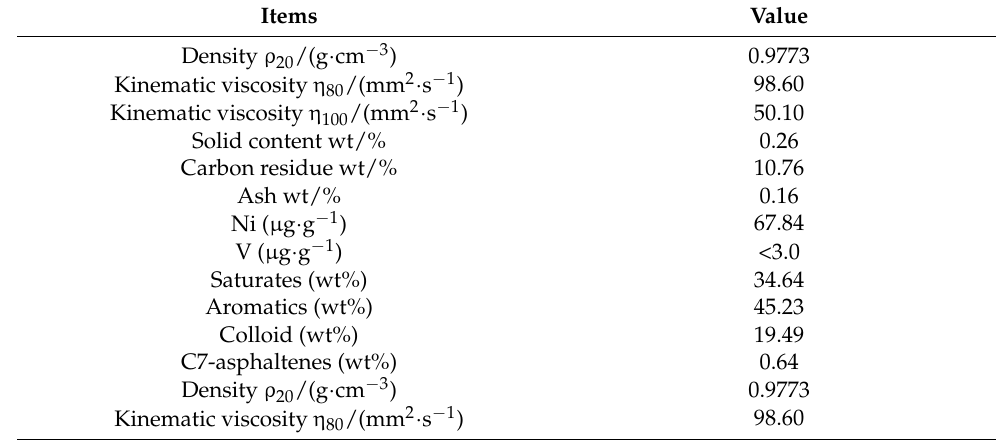
Table 1. Properties of the real SLO